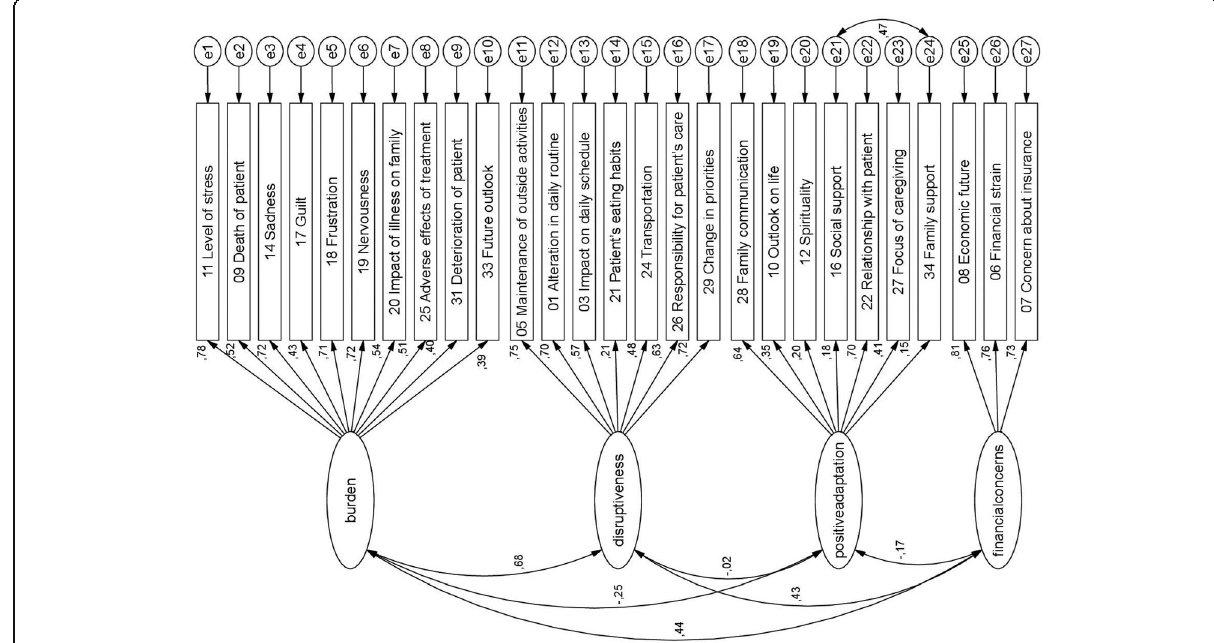
Fig. 1 Path model for the CFA of the German CQOLC with residual path